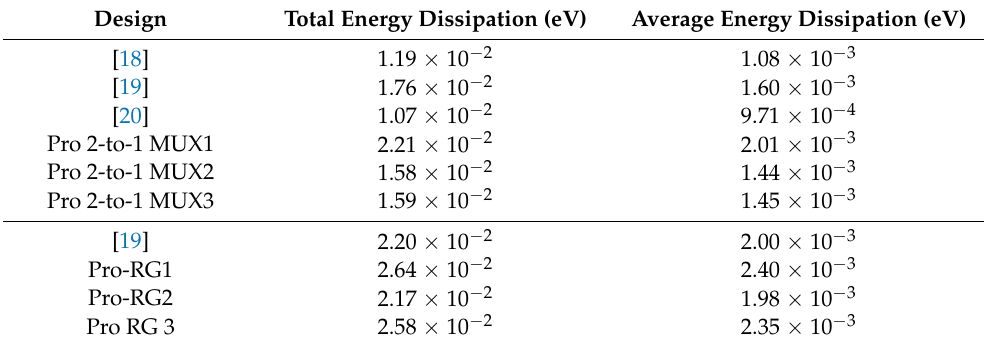
Table 8. Comparisons of the energy dissipation for alternative 2-to-1 multiplexers and reversible